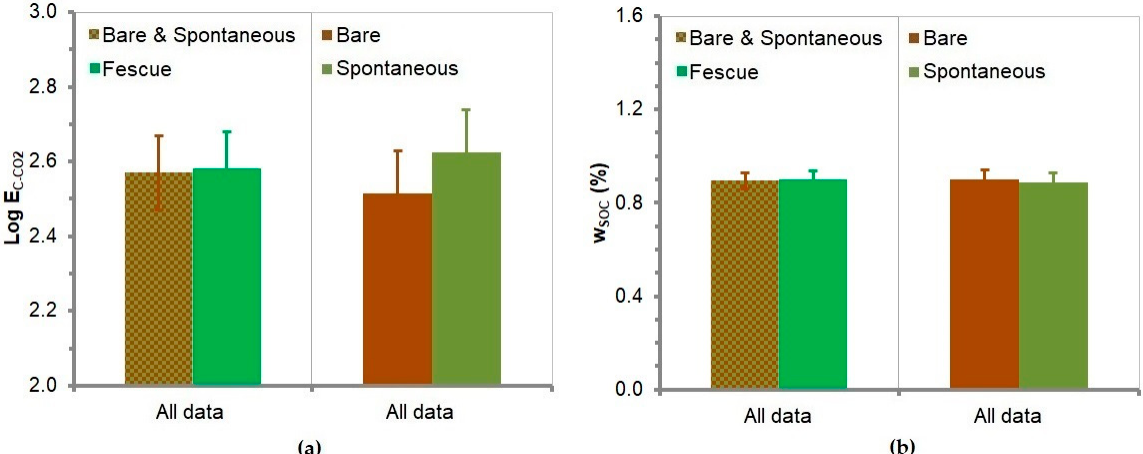
Figure 7. ( a ) logarithm to base 10 of the soil carbon dioxide emission ( E C-CO2 ) in the different treatments alongside the 95% confidence interval for the means according to the orthogonal contrasts based on the two-way ANOVA results; ( b ) soil organic carbon mass fraction ( w SOC ) at 0–20 cm in the different treatments alongside the 95% confidence interval for the means according to the orthogonal contrasts based on the two-way ANOVA results.